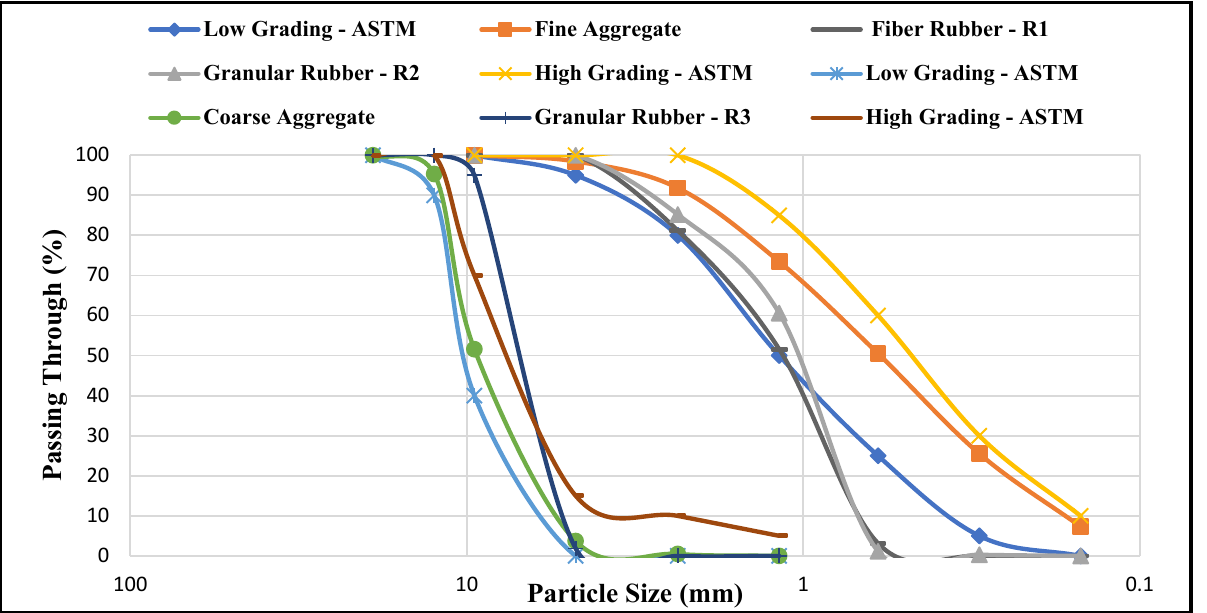
Figure 3. Grading Curve of natural and tire rubber aggregates in relation to ASTM C33 limits. A high-range water reducer was used to achieve the desired workability. The basic component of super plasticiser (SP) is synthetic polymers base, and it is a chloride-free product. The used SP meets the requirement of ASTM C494 for types A and F. This admixture is compatible with all types of cement. This type of SP is normally dispensed at a rate of 0.8 to 3 litres per 100 kilograms of cementitious material. Table 3 shows the typical properties of utilized SP. Table 3. Specific of used super plasticizer.